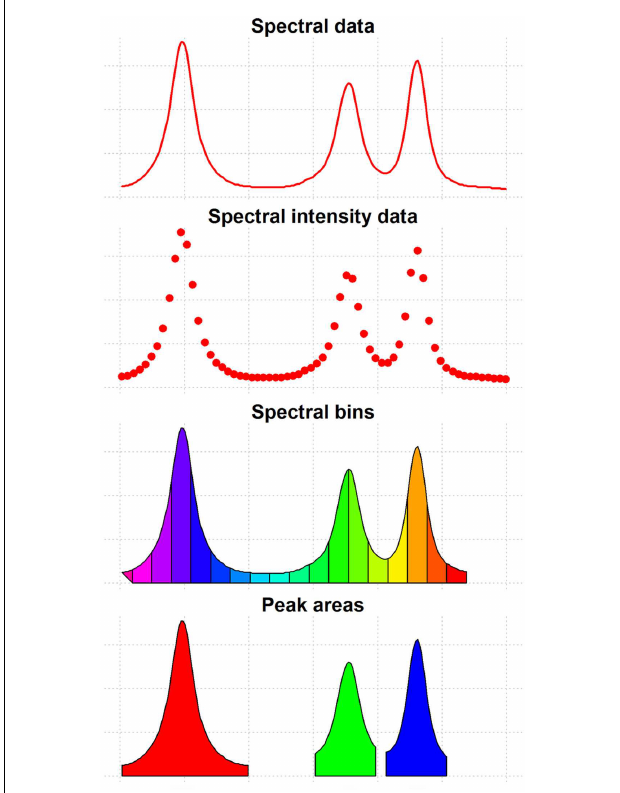
FIGURE 3 | Features of spectral data .This figure shows the different types of features that can be extracted from spectral data and used for data